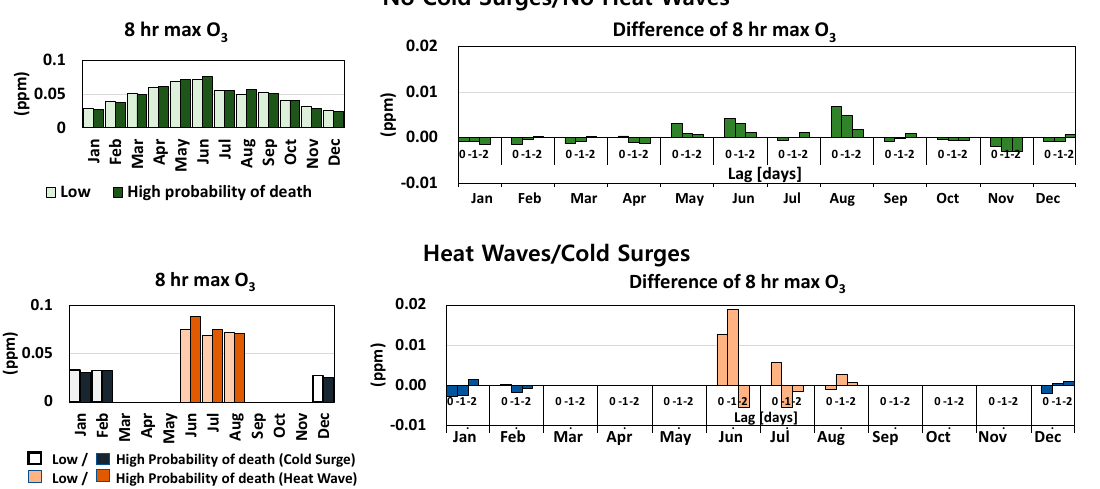
Figure 11. Comparison of monthly O 3 averages on days of high and low probabilities of death and the differences in O 3 (O 3 (high probability of death) –O 3 (low probability of death) ) from zero to two days before death. Monthly average temperatures did not cause a significant difference between H and L days for lag times from zero to two days (Figure 12). Temperatures on L days were lower